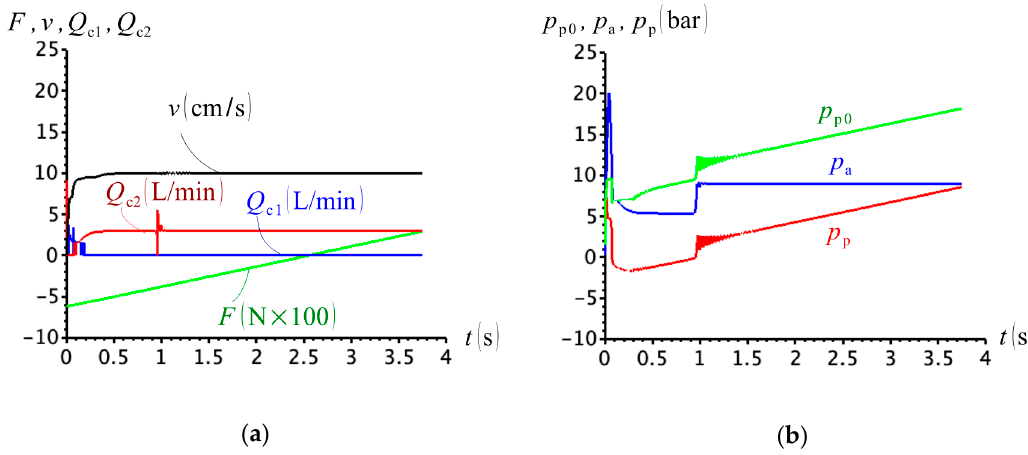
Figure 15. ( a ) External force, cylinder velocity and check valve flows; ( b ) circuit pressures ( m = 250 kg ).